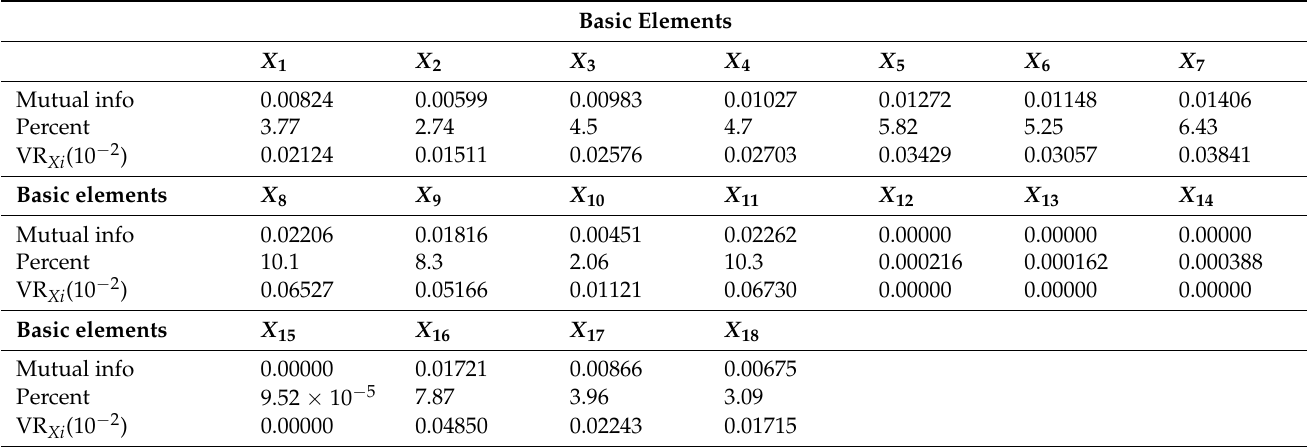
Table 3. The results of the sensitivity analysis. Basic